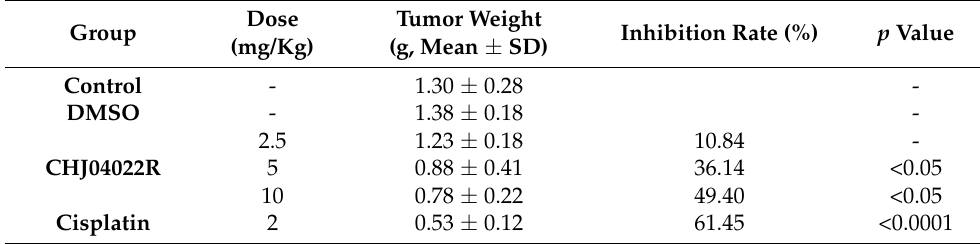
Table 5. Tumor weight of mice and inhibition